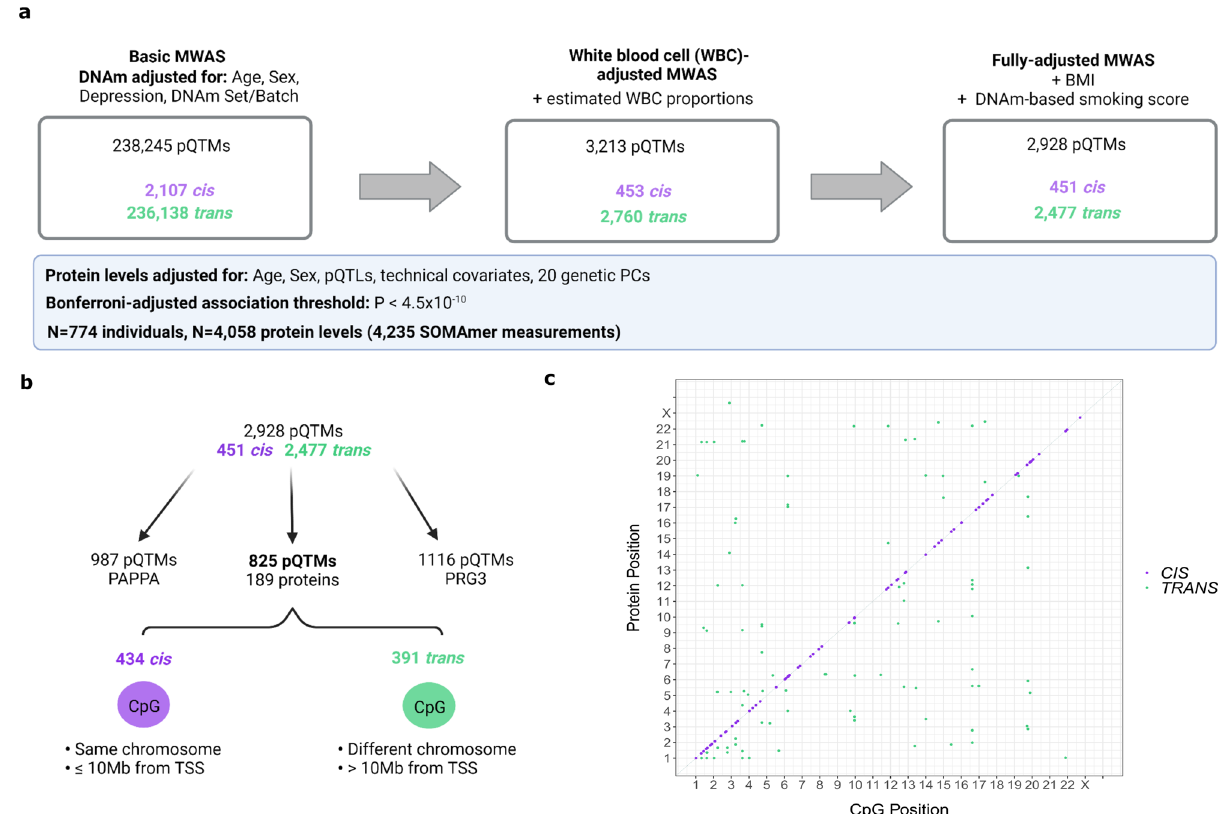
Fig. 2 | Methylome-wide association studies (MWAS) of 4058 plasma proteins. a Summary of MWAS results for 4058 protein levels in Generation Scotland ( N =774). The number of protein quantitative trait methylation loci (pQTMs) that had P <4.5×10 − 10 (Bonferroni threshold for multiple testing adjustment) in the basic, white blood cell proportion (WBC)-adjusted and fully-adjusted models. Cis associations (purple) and trans associations (green) are summarised for each model. Covariates used to adjust DNAm are described for each model. Normalised protein levels were adjusted for age, sex, 20 genetic principal components (PCs), protein quantitative trait loci (pQTLs) and technical variables and scaled to have a mean of 0 and standard deviation of 1. Results were generated through linear regression models. Full summary statistics with full P values can be accessed in Supplementary Data 6. Created with BioRender.com. b Flow diagram showing